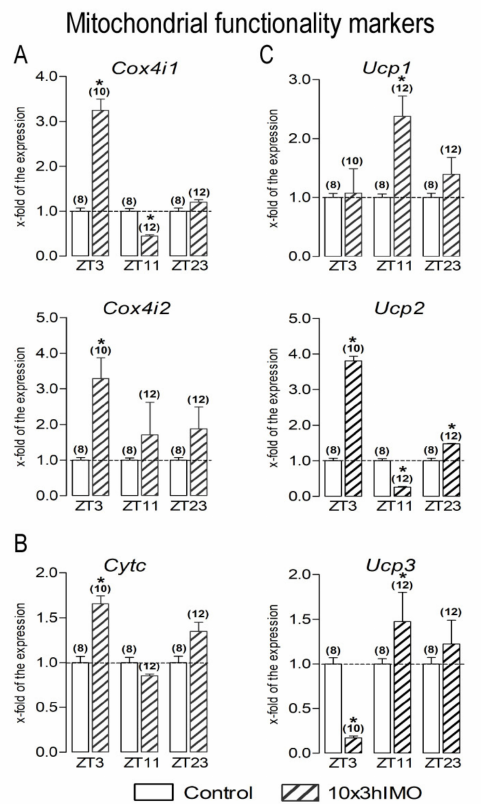
Figure 7. Different transcriptional profiles of mitochondrial functionality markers in spermatozoa of repeatedly stressed adult rats at different time points. Spermatozoa isolated from undisturbed and repeatedly stressed rats were used for RNA isolation and further analysis of the transcriptional profile of markers of mitochondrial functionality. Data bars are mean ± SEM values of two independent in vivo experiments (n = number of rats). Statistical significance was set at level p < 0.05: * vs. control group of the same time